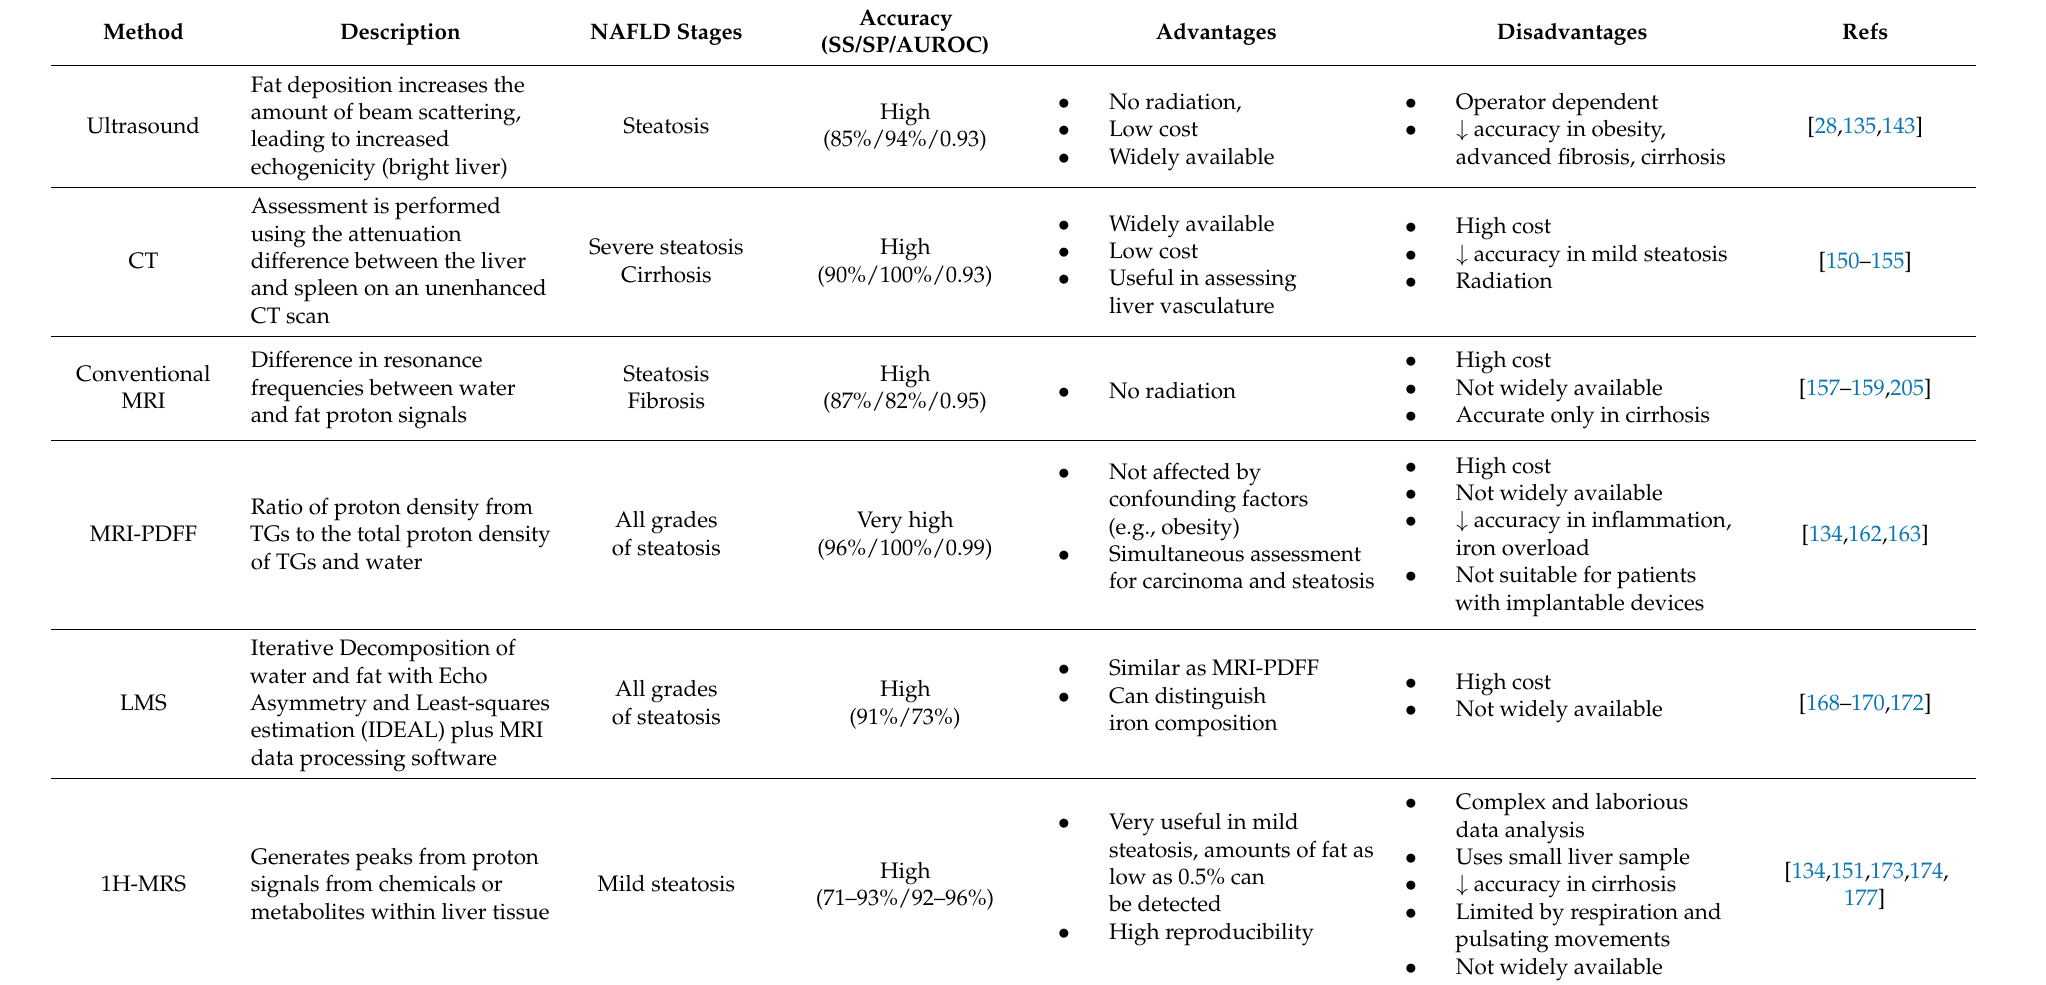
Table 2. Non-invasive imaging diagnostic modalities in